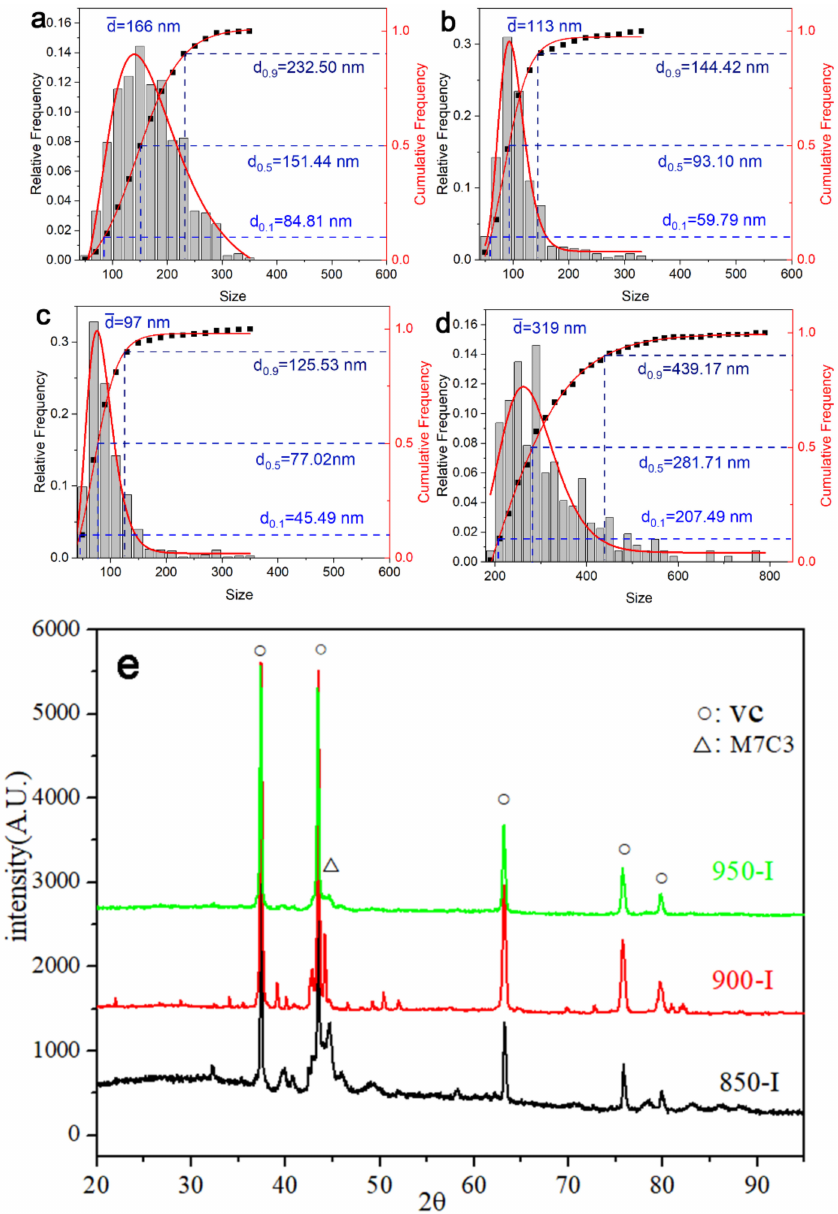
Figure 4. The precipitate sizes and XRD of the first stage I: ( a ) 850-I; ( b ) 900-I; ( c ) 950-I; ( d ) 0-I; and ( e ) XRD of 850-I, 900-I,